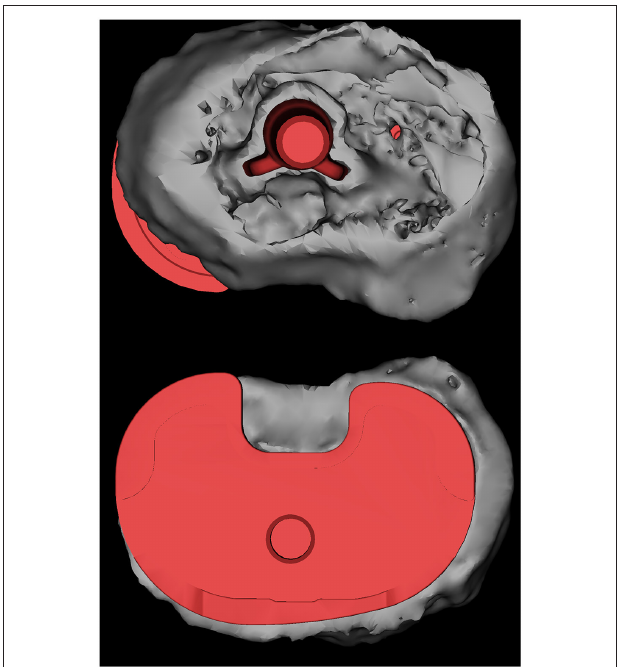
FIGURE 4 | The results of the 3D reconstruction of a patient are shown, with the HXLPE bearing, patella and patellar prosthesis, femoral stem, and a part of the tibial stem and fibula removed. The prosthesis was superposed by the corresponding type of prosthesis, and the placement of the prosthesis was determined by matching the results of the previous 3D reconstruction. A tibial plateau prosthesis with a posteromedial overhang is shown. HXLPE, highly cross-linked polyethylene.